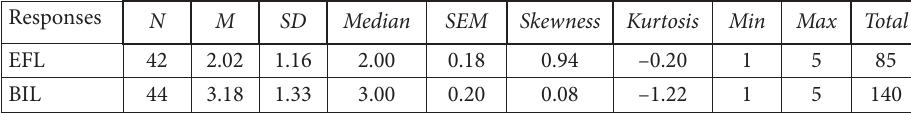
Table 3. Descriptive statistics of the scale items C – advanced familiarity with subject for English as foreign language (EFL) and bilingual (BIL) groups (source: created by authors)